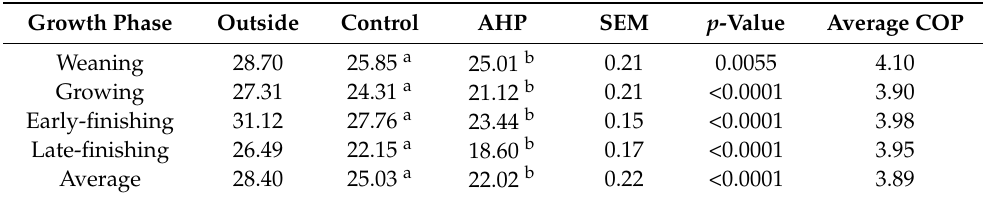
Table 2. Effect of the AHP cooling system on the inside temperature ( ◦ C) of the pig house and coefficient of performance